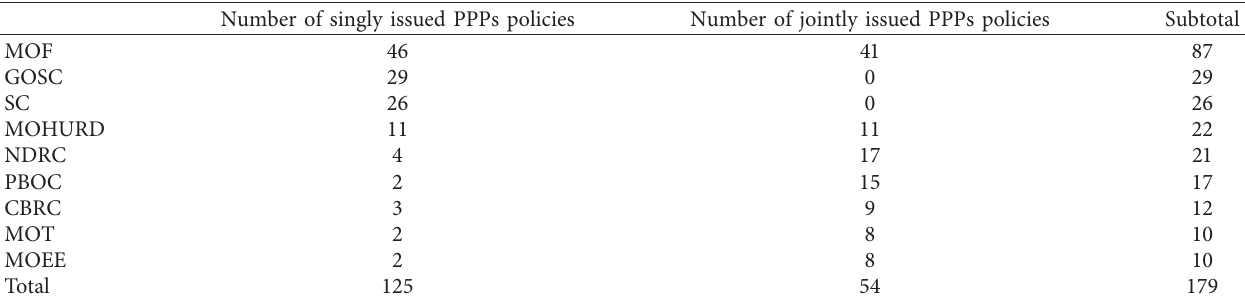
Table 3: Top 9 policy